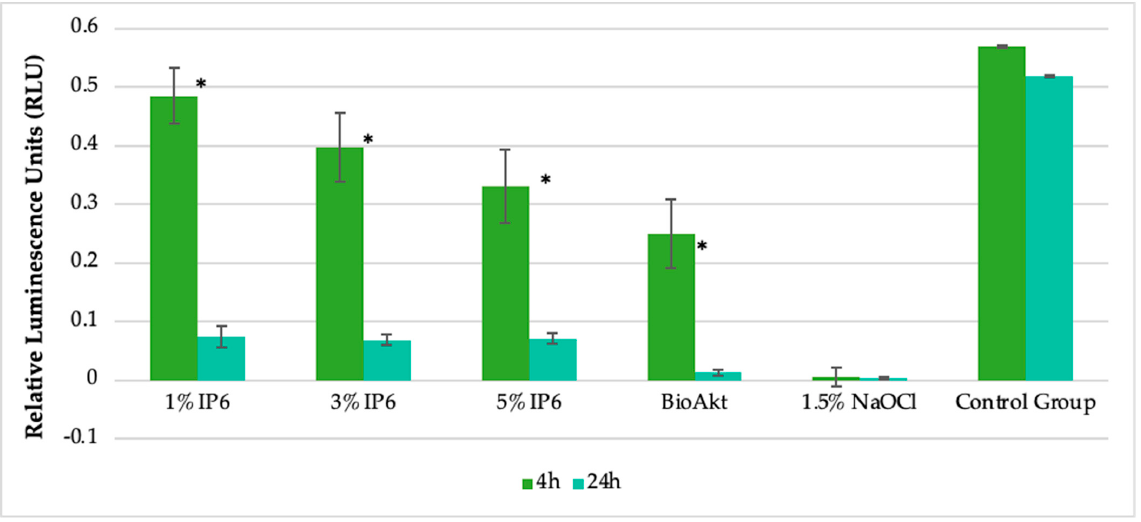
Figure 1. Crystal Violet Assay Results; * indicates statistically significant difference between 4 h and 24 h.